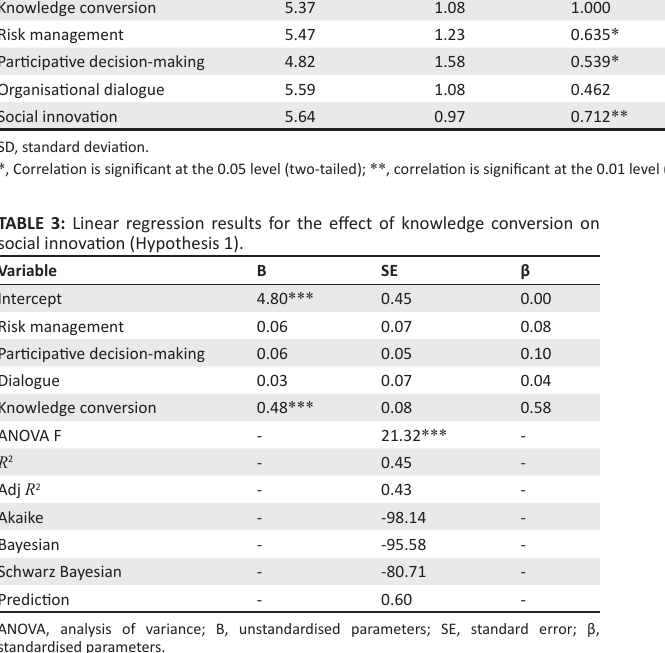
TABLE 2: Descriptives and correlation matrix for variables under study. Factor